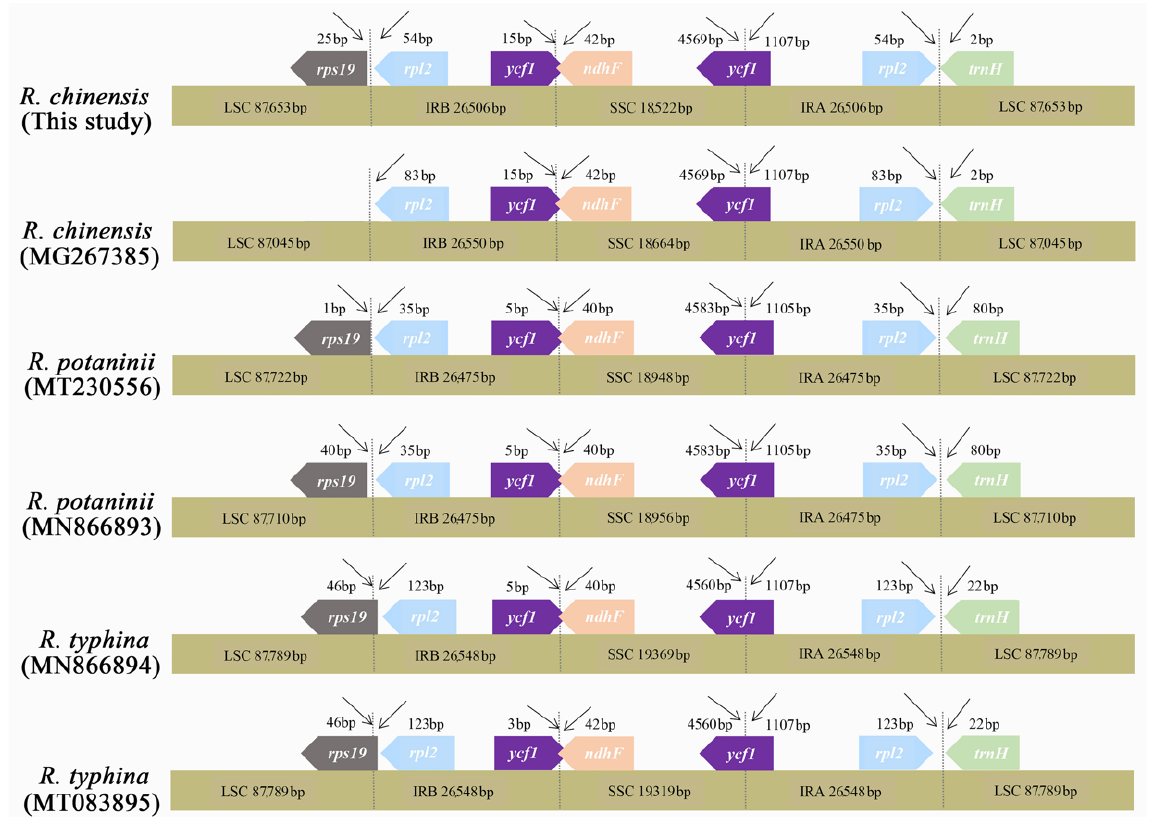
Figure 6. Comparison of the SC/IR junction regions for complete chloroplast genomes of Rhus species. The number above the gene features indicates the distance between the ends of the genes and the border sites. Features are not to scale .